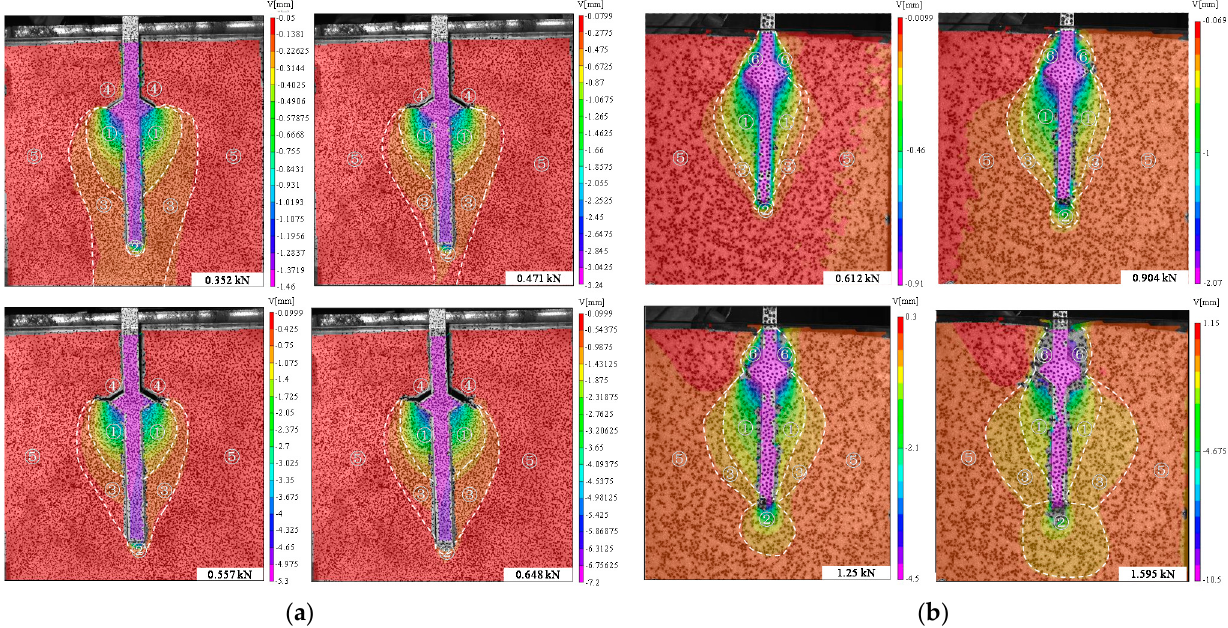
Figure 11. Soil deformation field around the expanded body under the load (V represents vertical displacement): ( a ) undisturbed soil; ( b ) sand.